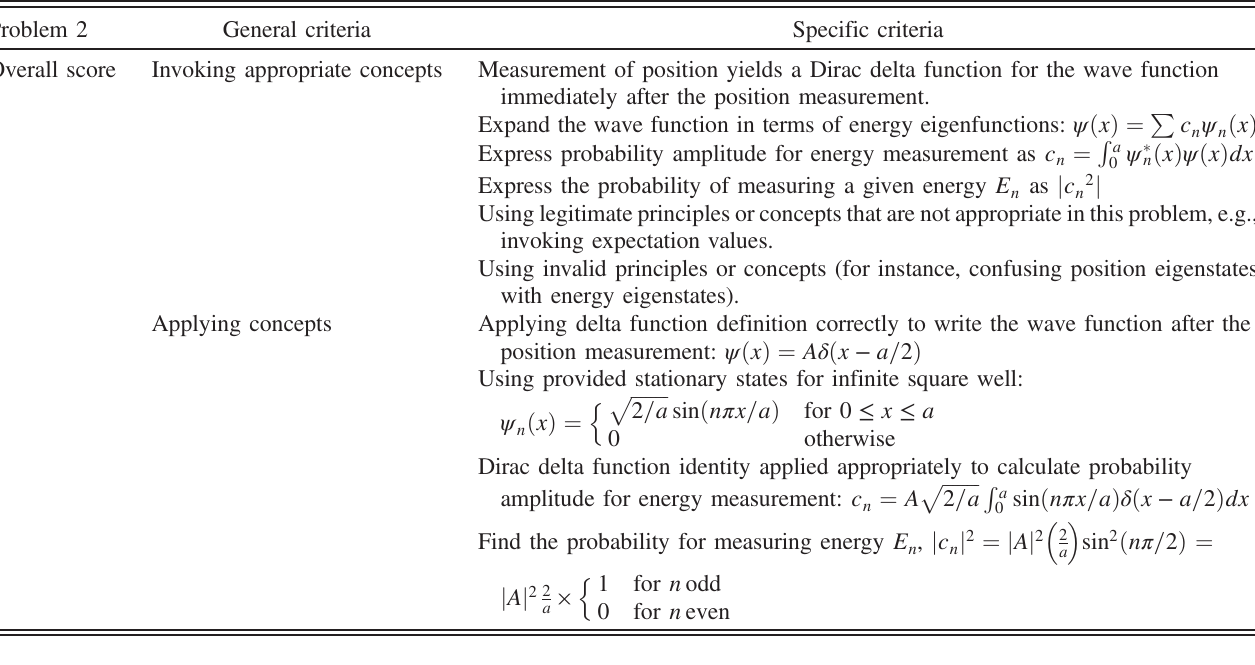
TABLE III. Summary of the rubric used to solve problem 2 (measurement problem). In this problem, a particle in a one-dimensional infinite square well is first measured to be at the center of the well. Students are asked to show that a subsequent energy measurement can yield any odd-integer energy state with equal probability.